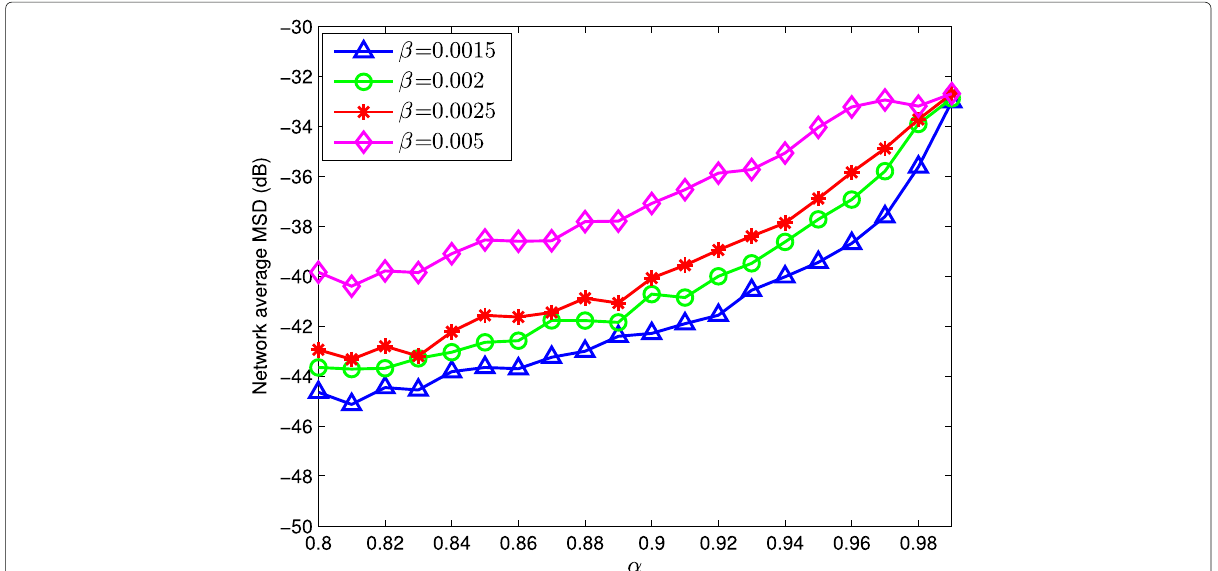
Fig. 3 Steady-state MSD versus α for different values of β for the LTVFF